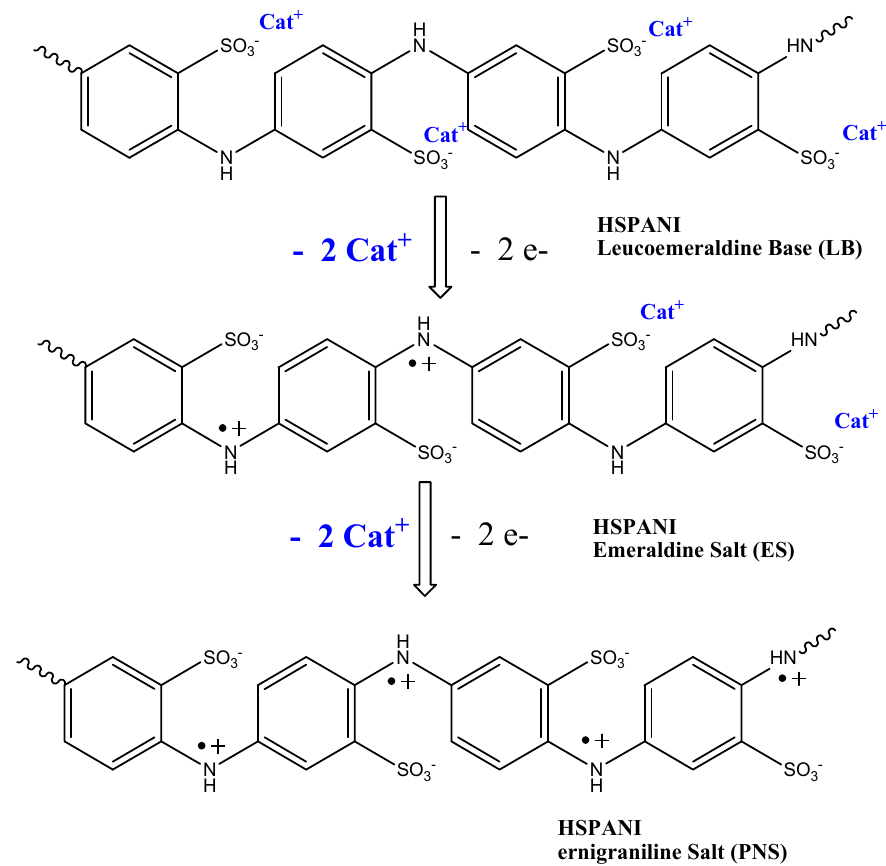
Scheme 5. Redox-coupled ion exchange of HSPANI. Cat + represents a cation (e.g., Li +